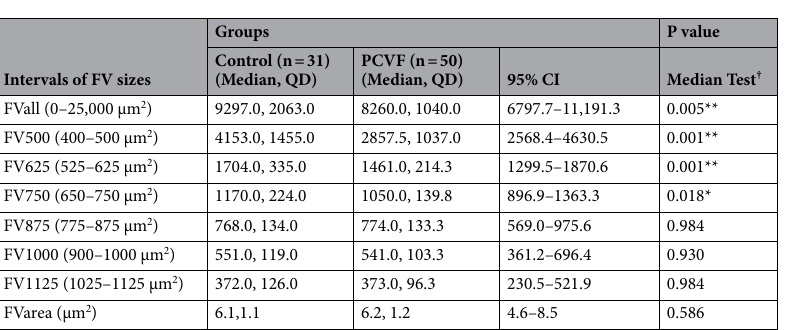
Table 2. The number of the flow void in different sizes. QD quartile deviation, Control age-matched control group, PCVF PCV fellow eyes. † Independent-samples median test. *P < 0.05, **P < 0.01.